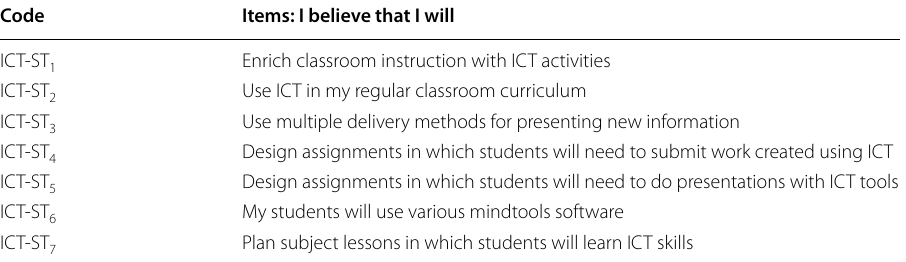
Table 1 Internal content of latent variable: ICT self-efficacy in teaching (ICT-ST) Code Items: I believe that I